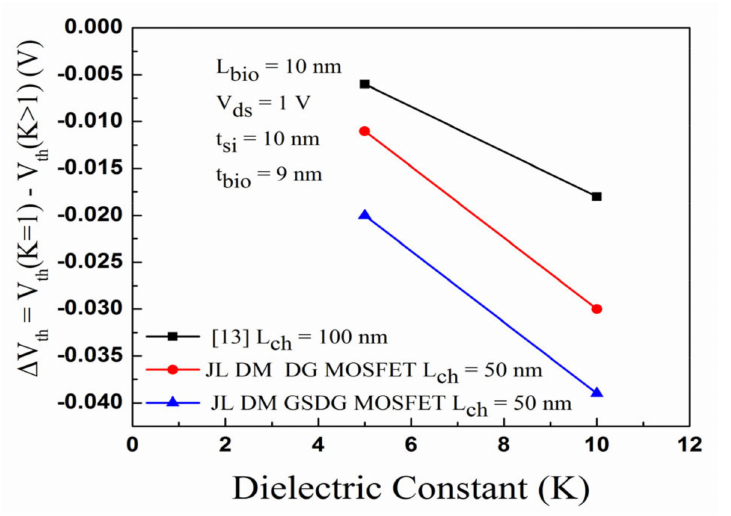
Figure 11. Plot of the sensitivity factor ( ∆ V th ) for JL-DM-DG-MOSFET, JL-DM-GSDG-MOSFET, and [13] for neutral biomolecules.